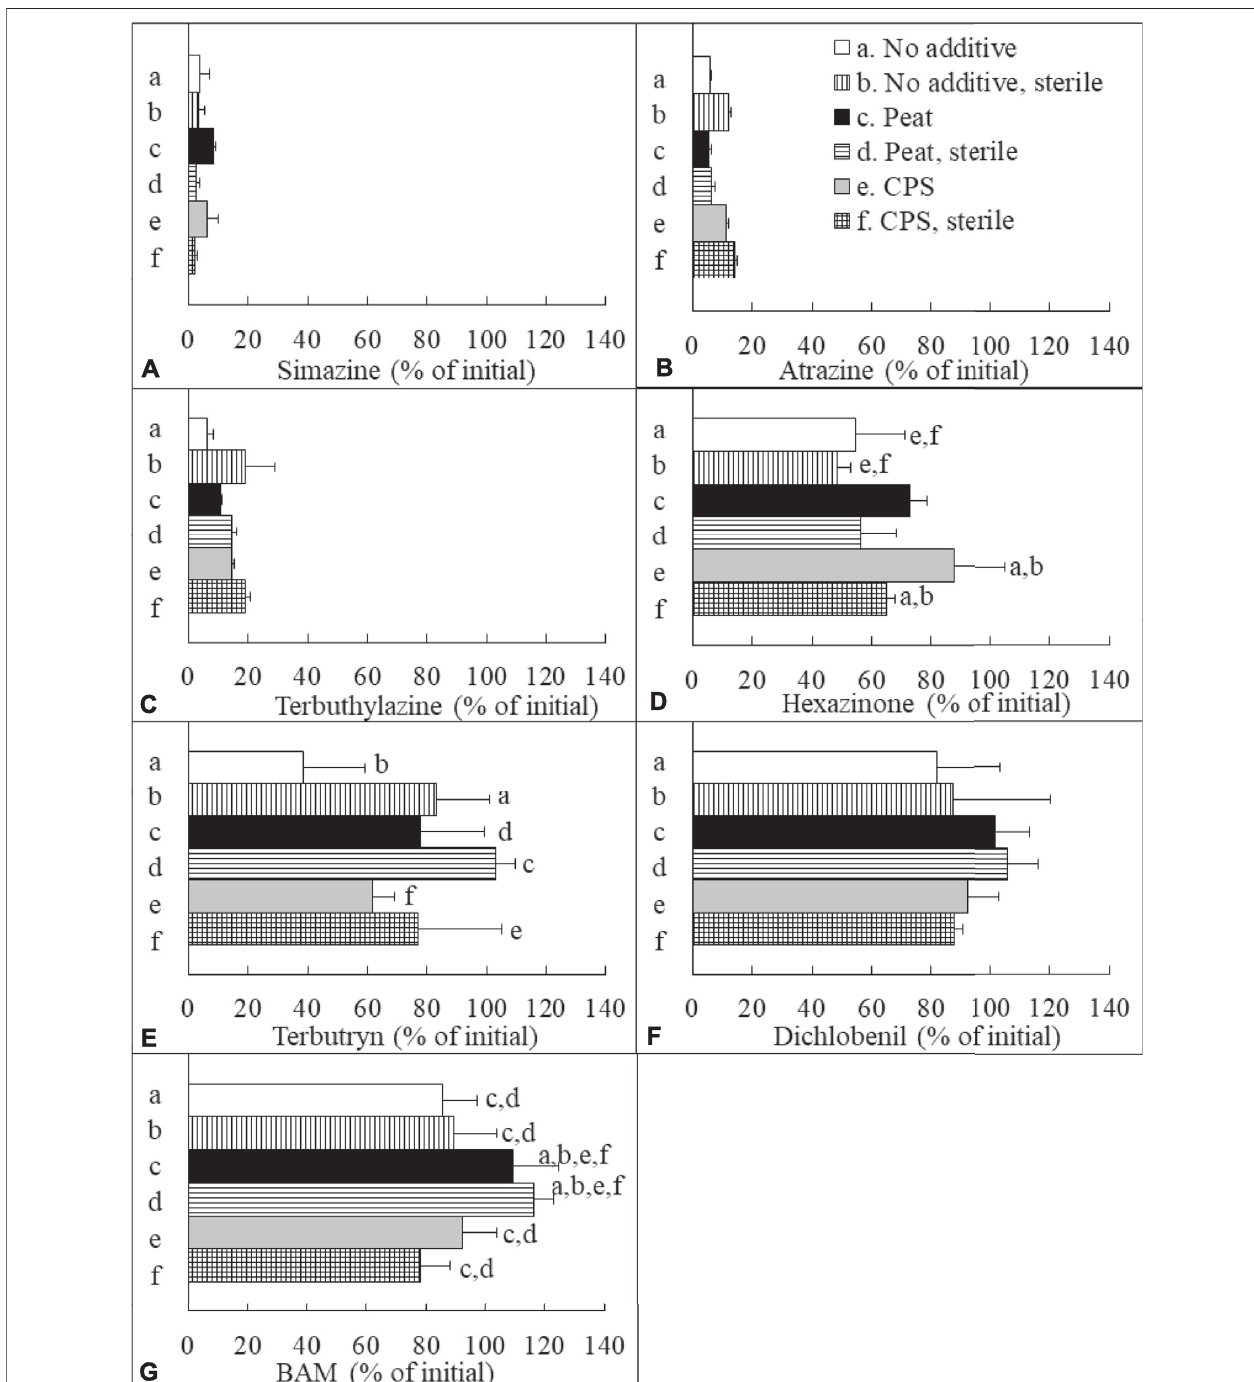
FIGURE2|(A) Simazine, (B) atrazine, (C) terbuthylazine, (D) hexazinone, (E) terbutryn, (F) dichlobenil,and (G) 2.6-dichlorobenzamide(BAM)concentrationsas% of the initial in the organic soil after 241 days incubation without or with peat or compost-peat-sand (CPS) addition, including sterilized counterparts. (a) Soil without additives, (b) sterilized soil without additives (c), soil with peat (d) sterilized soil and peat, (e) soil with CPS, (f) sterilized soil and CPS. The error bars indicate standard deviations (n (cid:2) 3), and the letters next to the bars show statistically signi fi cant differences (Kruskal-Wallis test followed by Mann-Whitney ’ s test).